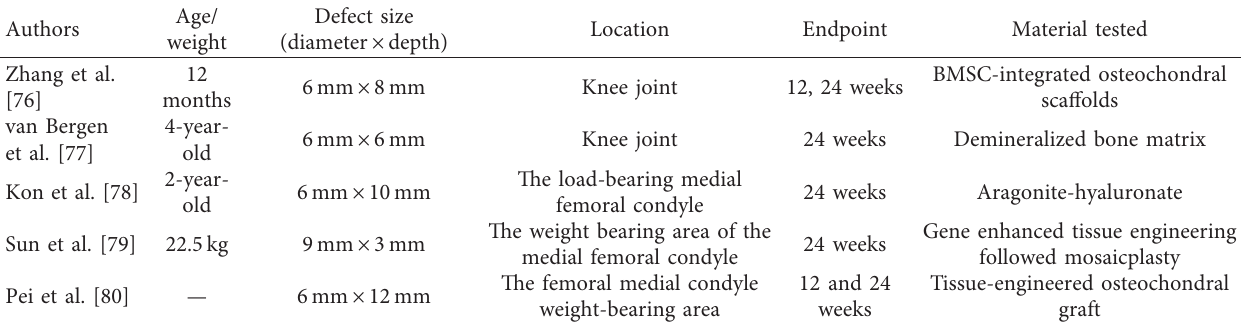
Table 7: Examples of studies using goat osteochondral defect models.